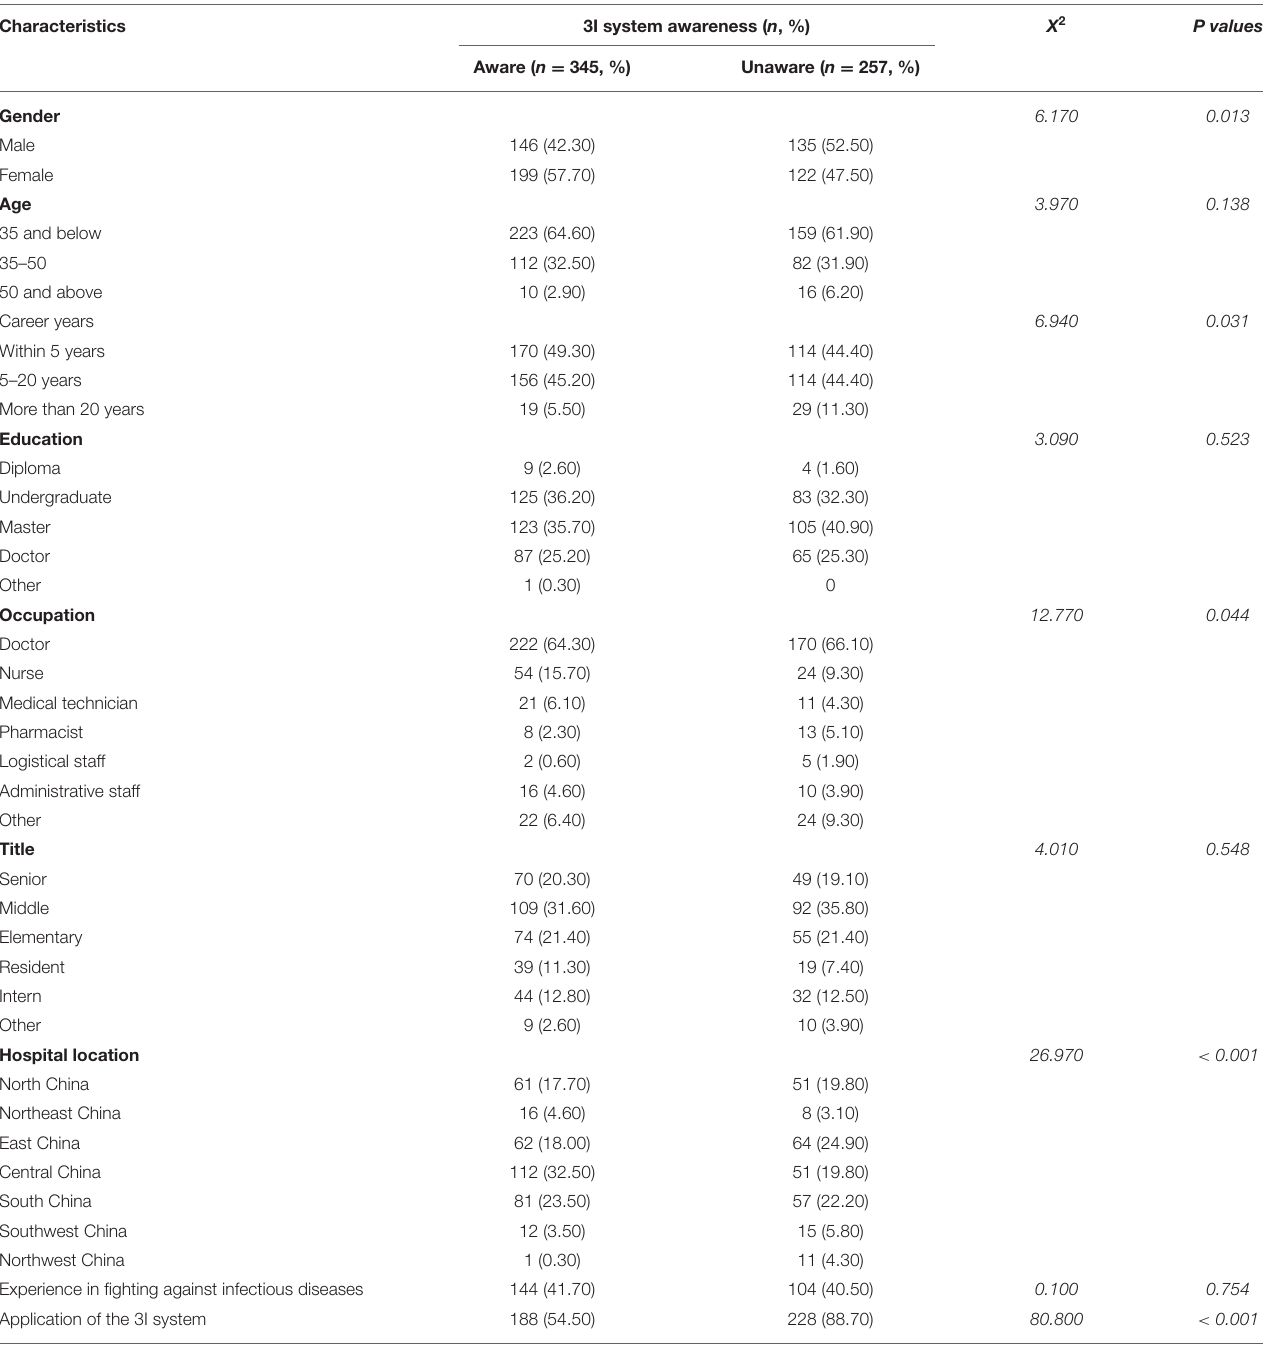
TABLE 4 | Knowledge about 3I system among health care workers during COVID-19 pandemic.